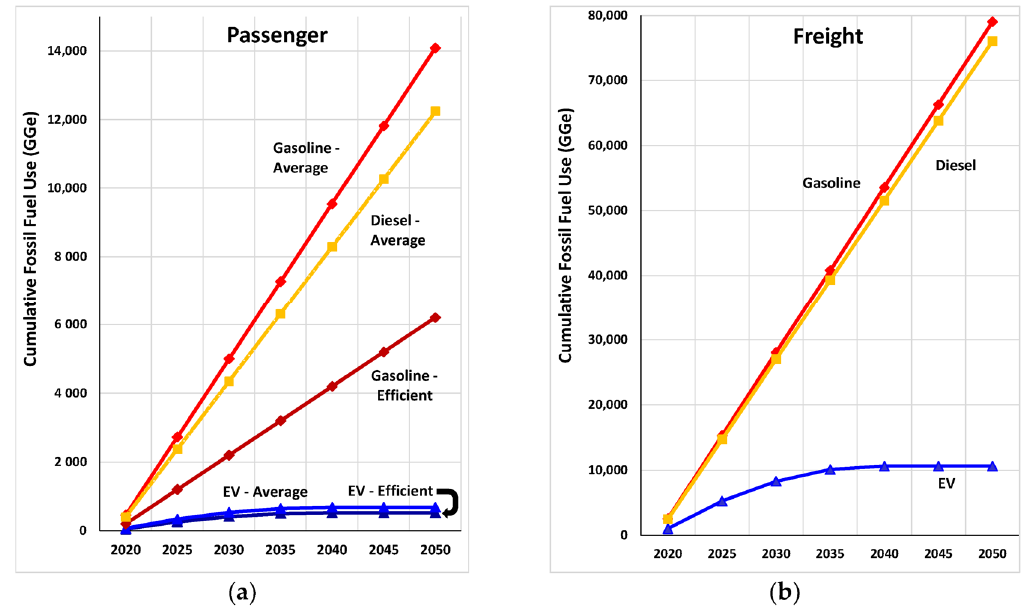
Figure 9. Cumulative vehicle fossil fuel use from 2020 to 2050 on Oahu under the faster renewable power projection: ( a ) Passenger; ( b )